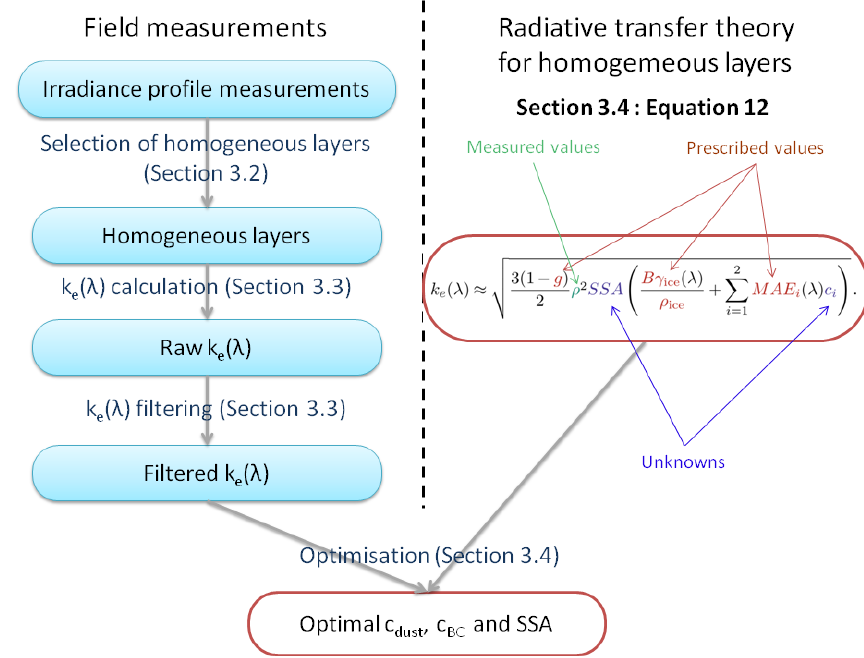
Figure 7. Scheme synthesising the principle of the LAP retrieval method presented in Sect. 3.